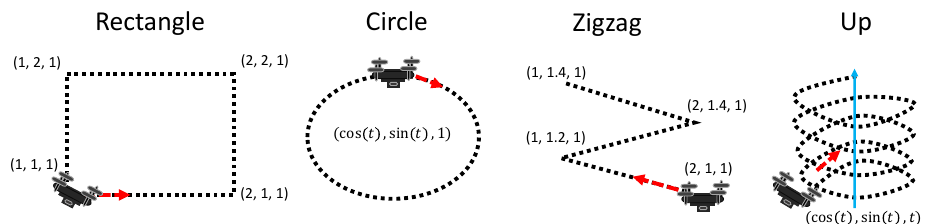
Figure 6. Four types of trajectories for the test of position frequency.